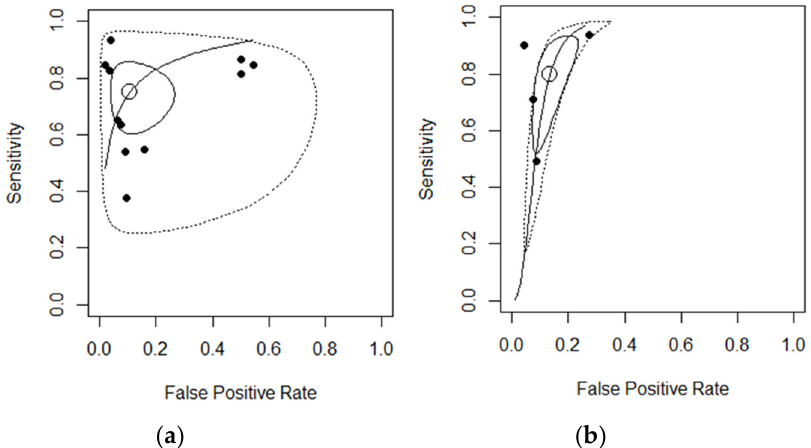
Figure 5. ( a ) The summary receiver operating characteristic (ROC) curve of MRI studies excluding two histopathology studies, ( b ) and summary ROC curve of US studies excluding one histopathology study.